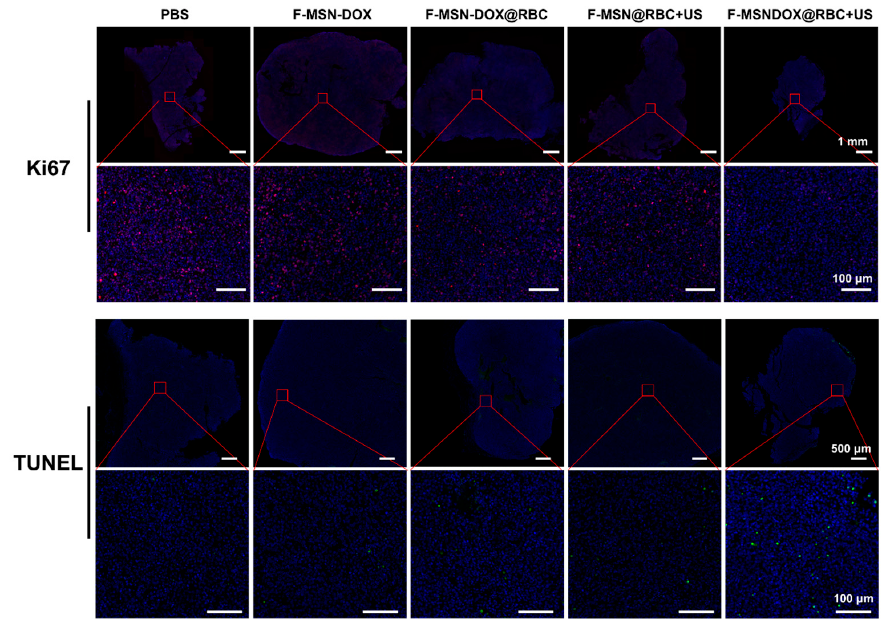
Figure 8. Ki67 and TUNEL immunofluorescence staining of the proliferation and apoptosis of tumor cells. The scale bar is 1 mm for Ki67 and 500 µm for TUNEL in the upper row, and all the scale bars in the lower row are 100 µm.